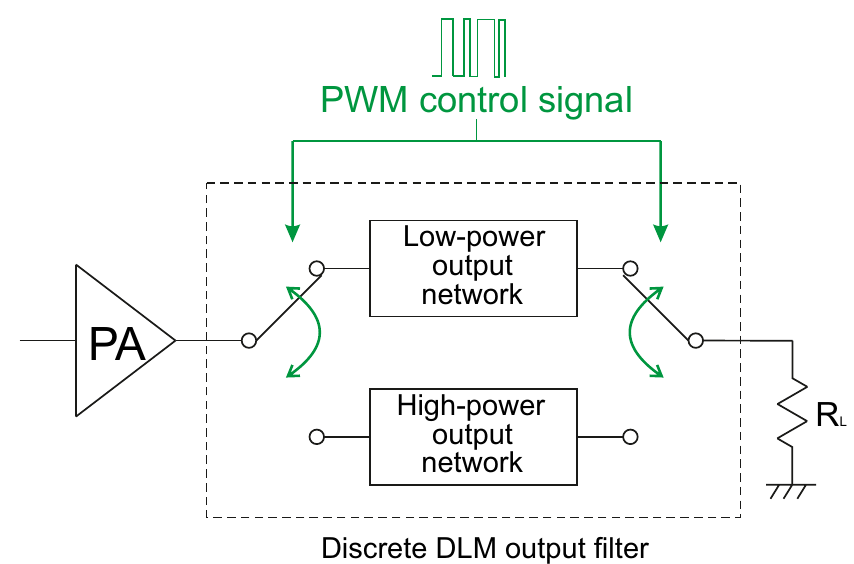
Figure 18. Discrete Dynamic Load Modulation. PWM: Pulse-Width